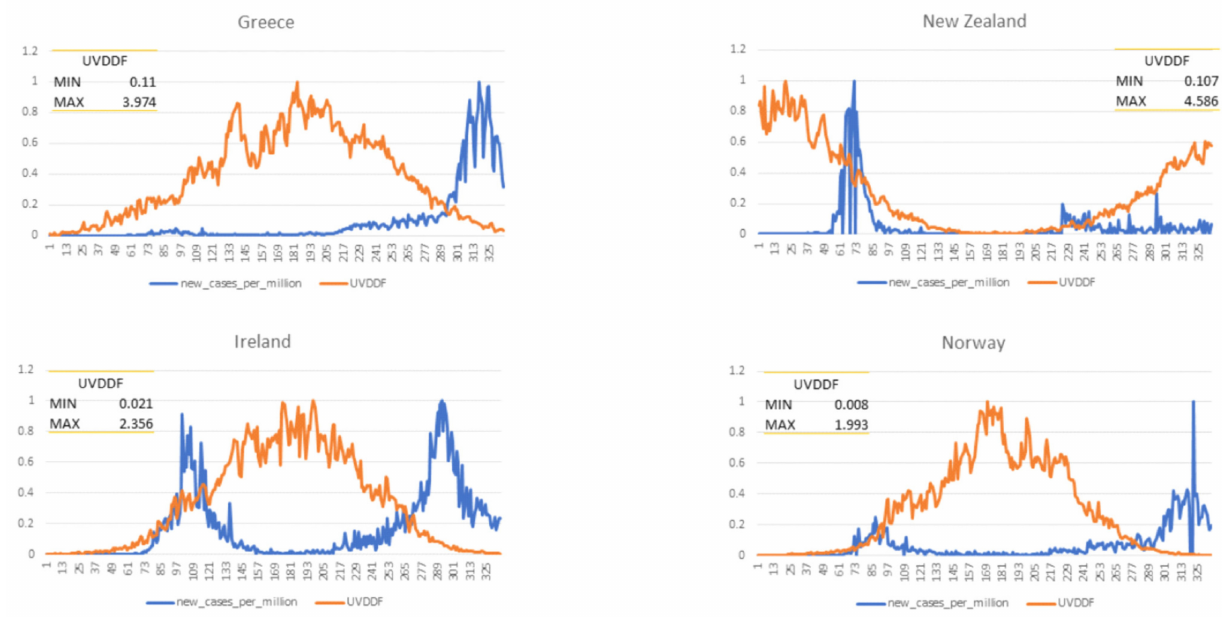
Figure 4. Time course of UVDDF and Covid-19 cases across target countries. Days are reported for the period 1 January– 30 November ( x -axis) and UVDDF levels (min-max normalized; y -axis, orange line). Covid-19 cases are reported (min-max normalized, y -axis, blue line). Absolute minimum and maximum values of UVDDF are also shown for each country, within